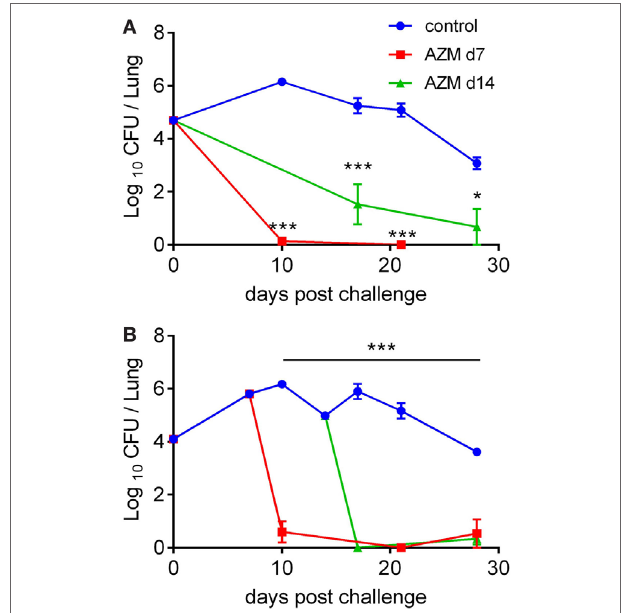
FigUre 1 | Course of Bordetella pertussis infection in azithromycin (AZM)-treated mice. C57BL/6 mice were infected by aerosol challenge with B. pertussis and treated with AZM on 7 or 14 days post challenge. The control group of mice received DMSO. The course of infection following a high (a) and a low (B) initial infection dose. The results are mean ( ± SEM) CFUs on lung homogenates for five mice per group at each timepoint. Statistical significances were determined via two-way ANOVA followed by Sidak’s multiple comparisons test, * p < 0.05, *** p <